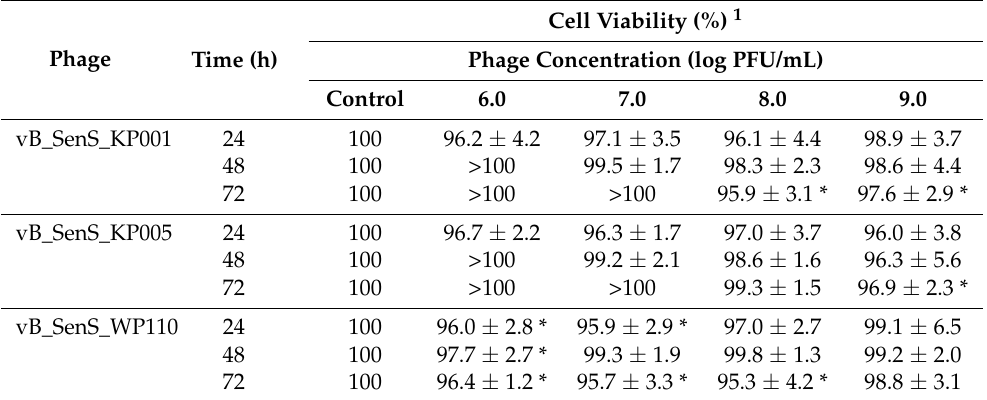
Table 5. Cell viability (%) of Caco-2 cells after treatment with a single